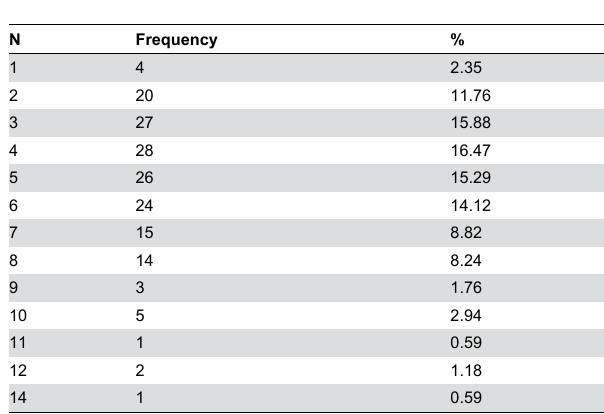
Table 1. Number of sticks per stack (N) observed in 170 stacks from Epon sections of P. deceptionensis M1 T cells processed by HPF-FS.